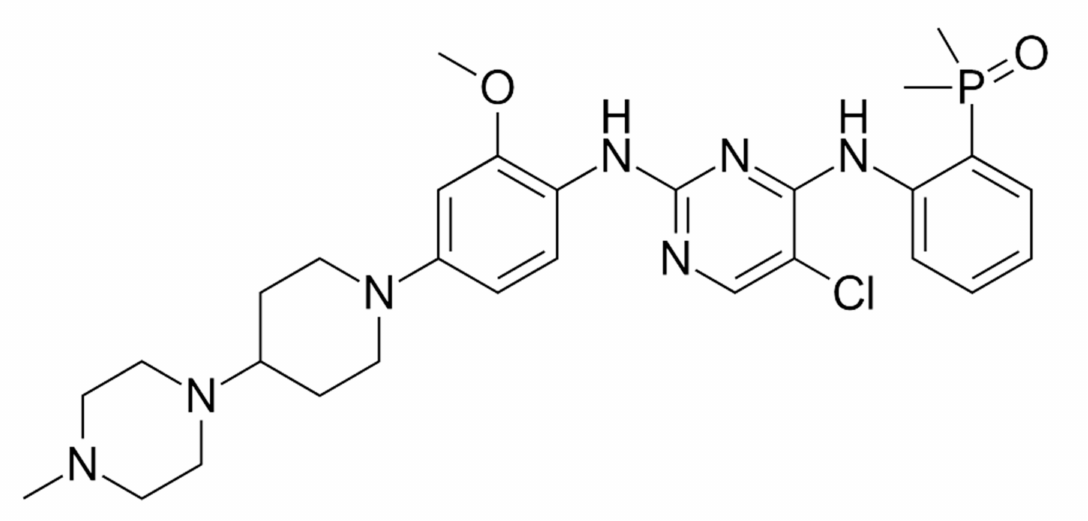
Figure 11. Brigatinib—a second-generation ALK TKI.